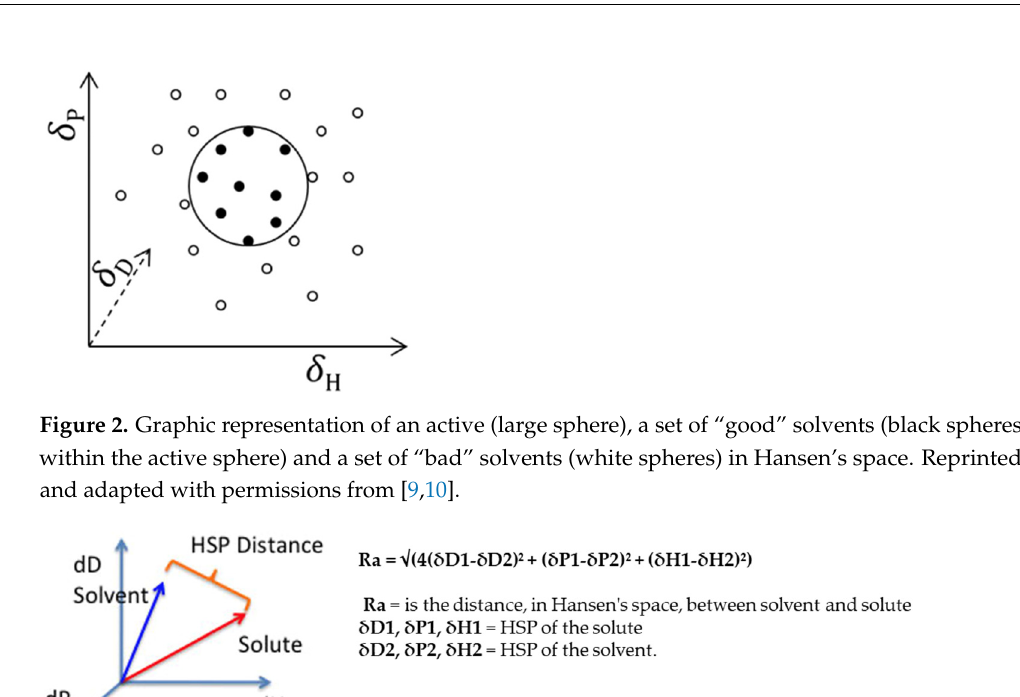
Figure 3. Equation and graphical representation of Ra (HSP distance) between a solute and a solvent in Hansen’s space. Reprinted and adapted with permissions from [9,10].